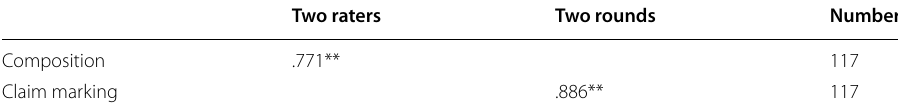
Table 5 Correlation coefficient of two review results